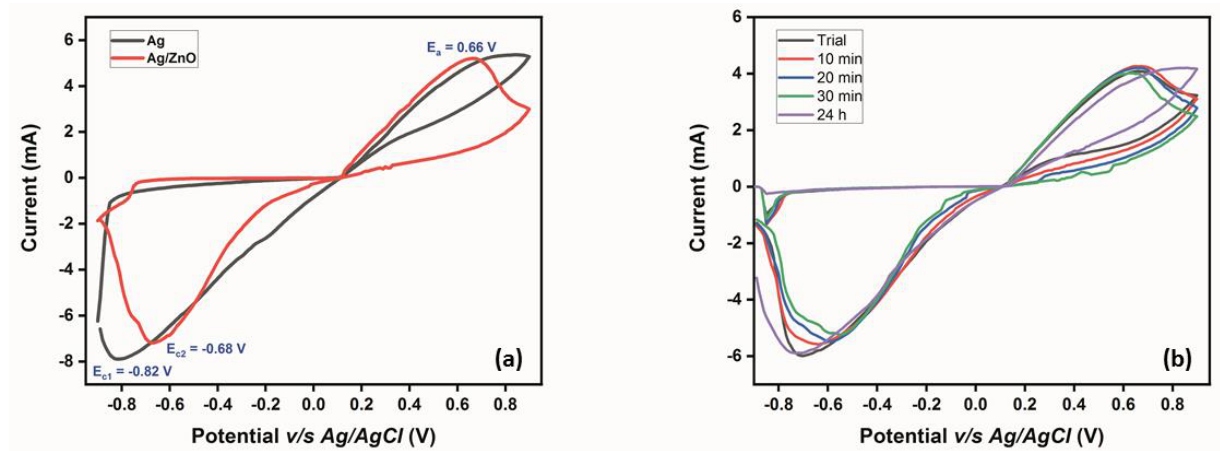
Figure 6. ( a ) CV profile of the Ag-sputtered micropipette tip and ZnO grown over Ag-sputtered micropipette tip, exhibiting a cathodic peak at -0.82 V and redox peaks at 0.66 V and -0.68 V, respec- tively in 0.1 M NaCl electrolyte at a scan rate of 0.1 V/s. ( b ) Stability profile from CV studies of the ZnO-modified micropipette tip for 24 h and different intervals in